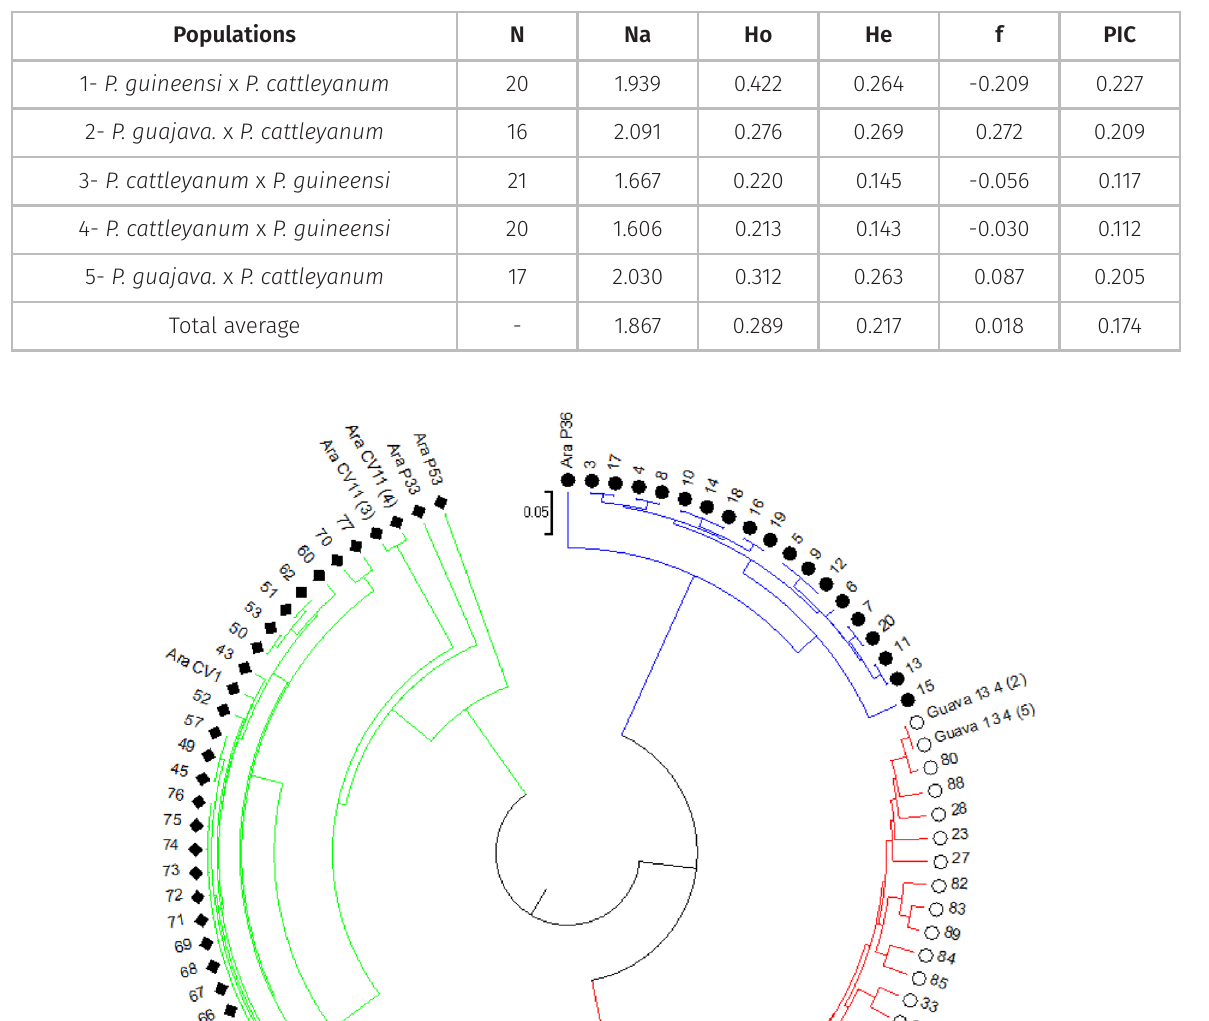
Table IV. Number of individuals (N), average number of alleles (Na), observed heterozygosity (Ho), expected heterozygosity (He), fixation index (f), and polymorphic information content (PIC) estimated for the five populations obtained from interspecific crosses of Psidium spp.